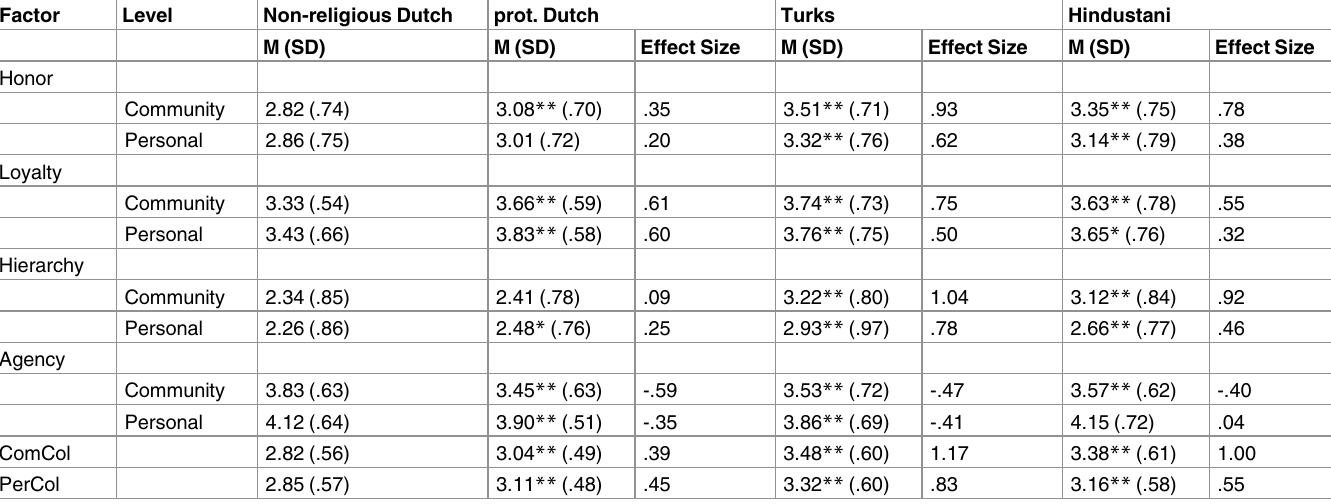
Table 7. CCS means and effect sizes of non-religious Dutch vs other groups on Community Collectivism Scale. Factor Level